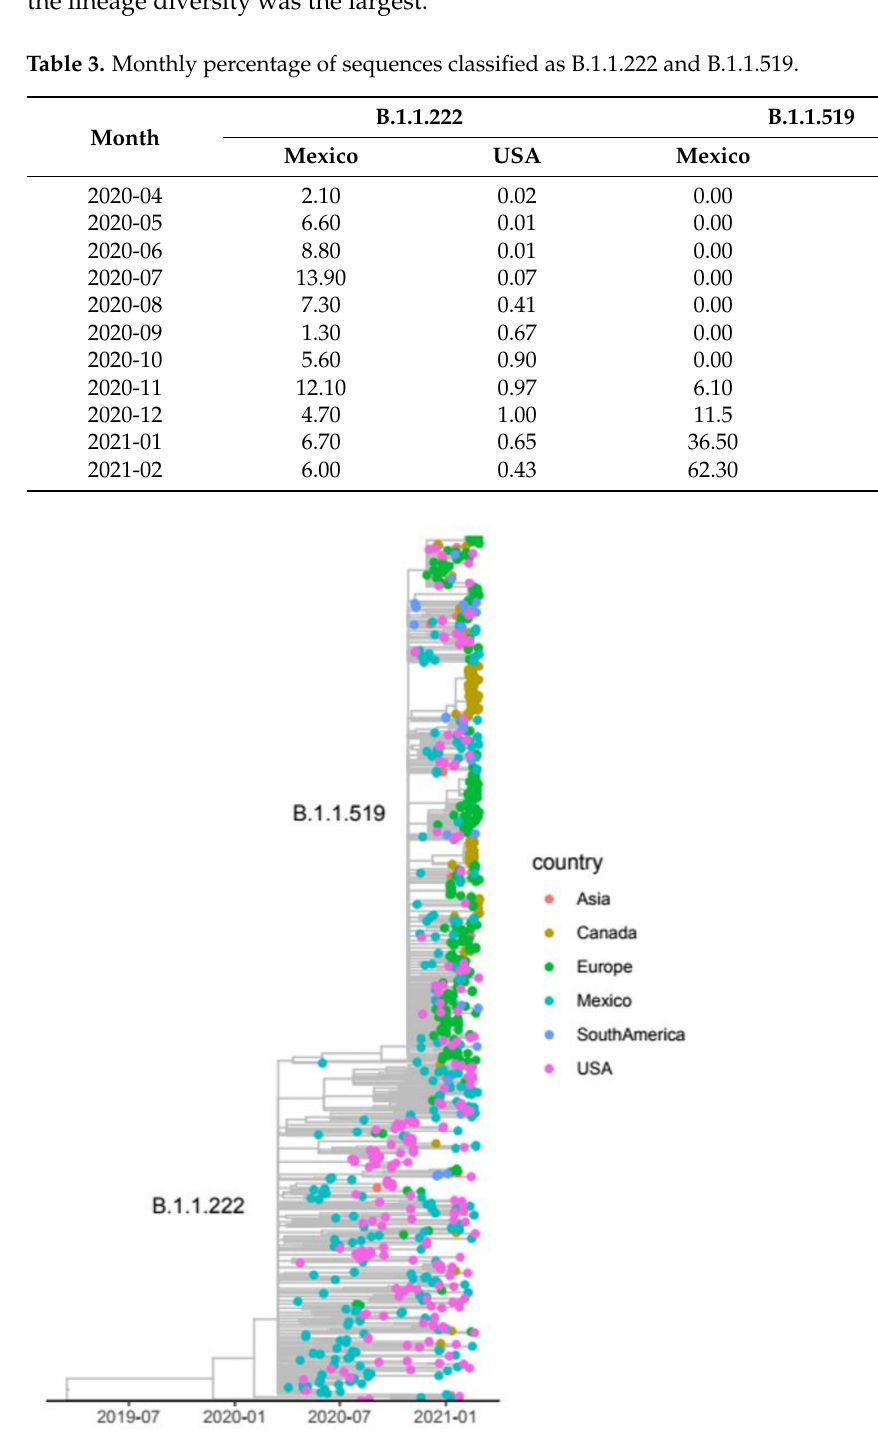
Figure 8. Maximum likelihood time-scaled phylogeny of lineages B.1.1.222 and B.1.1.519. The tips of the tree are colored by country/continent of